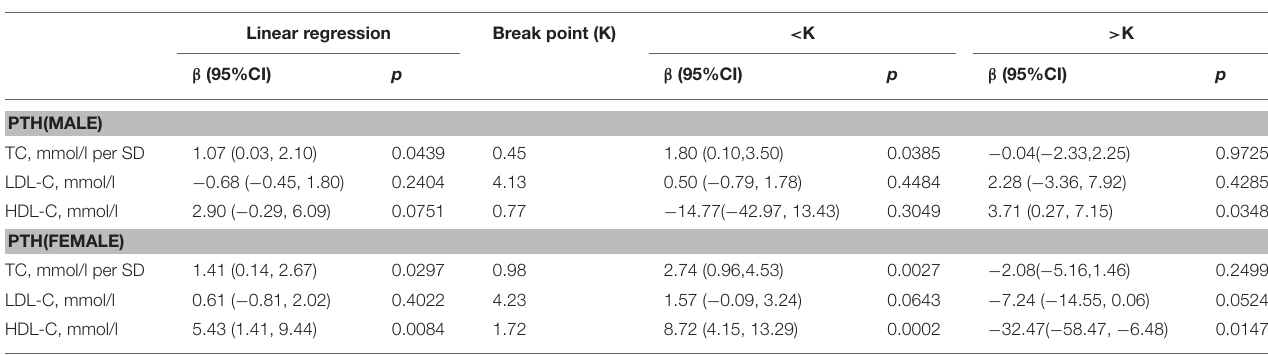
et al. (16) observed a cross-sectional association between HDL-C level and trabecular BMD but not between HDL- C level and cortical BMD or integral BMD at the hip or